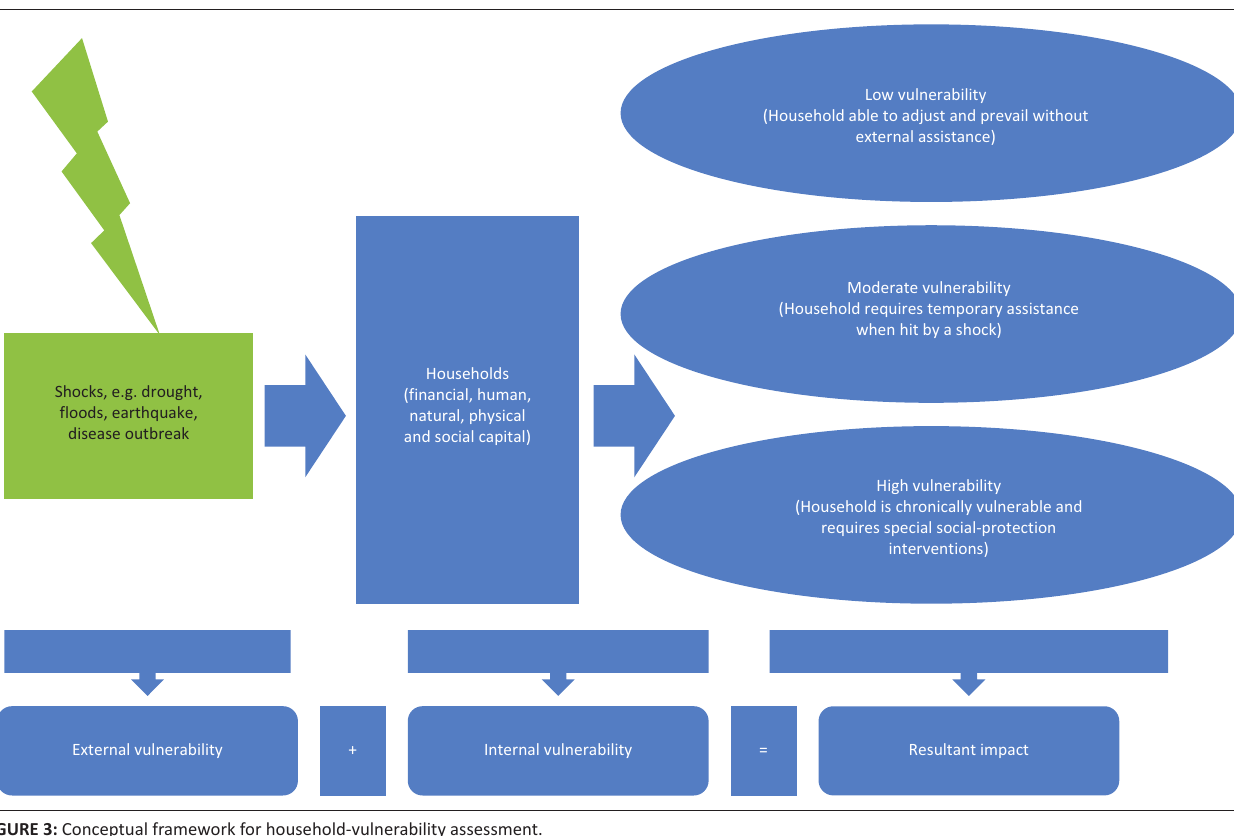
FIGURE 3: Conceptual framework for household-vulnerability